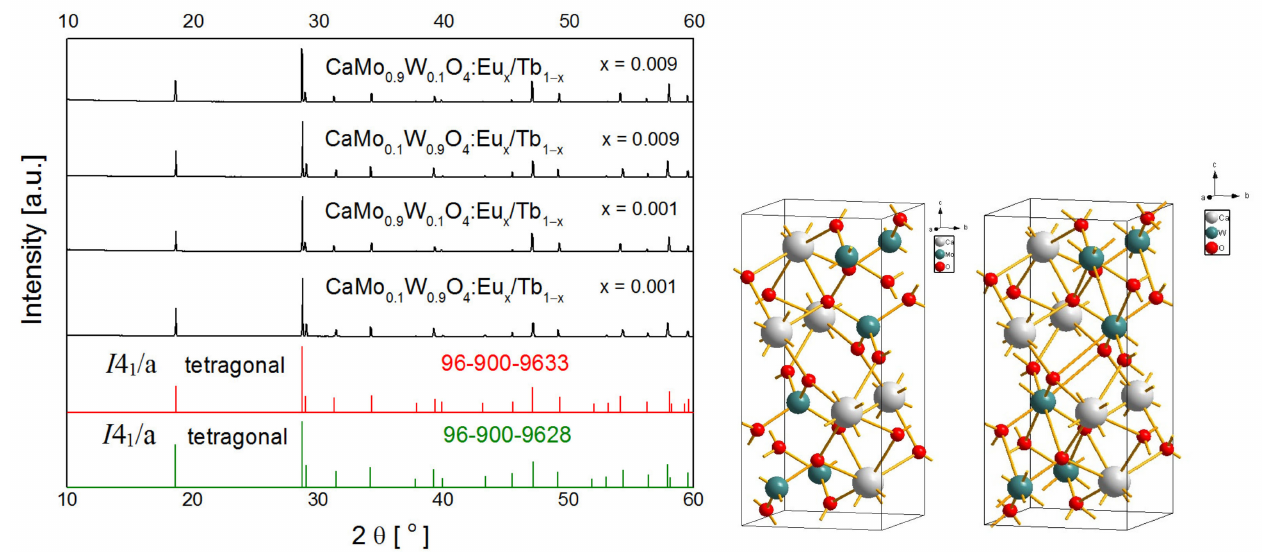
Figure 1. XRD patterns of CaMo 0.9 W 0.1 O 4 and CaMo 0.1 W 0.9 O 4 materials doped with Eu 3+ x /Tb 3+ 1 − x (x = 0.001, x = 0.009), synthesized at 900 ◦ C for 4